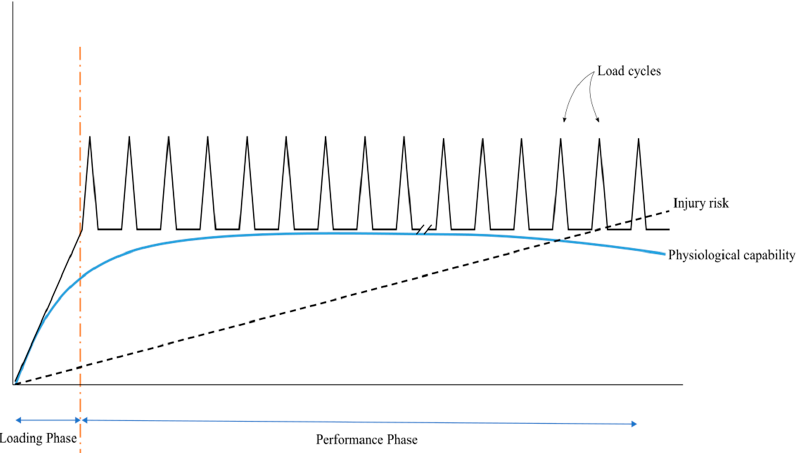
Figure 4. Loading and performance stages of greyhound training and racing. Young dogs are introduced to the stressors of racing during the load phase, and after 6–7 load cycles they commence racing in the performance phase. While the load cycles create a performance curve that is limited by the greyhound’s physiological capabilities, with increasing number of load cycles and little time for recovery, the risk of injury